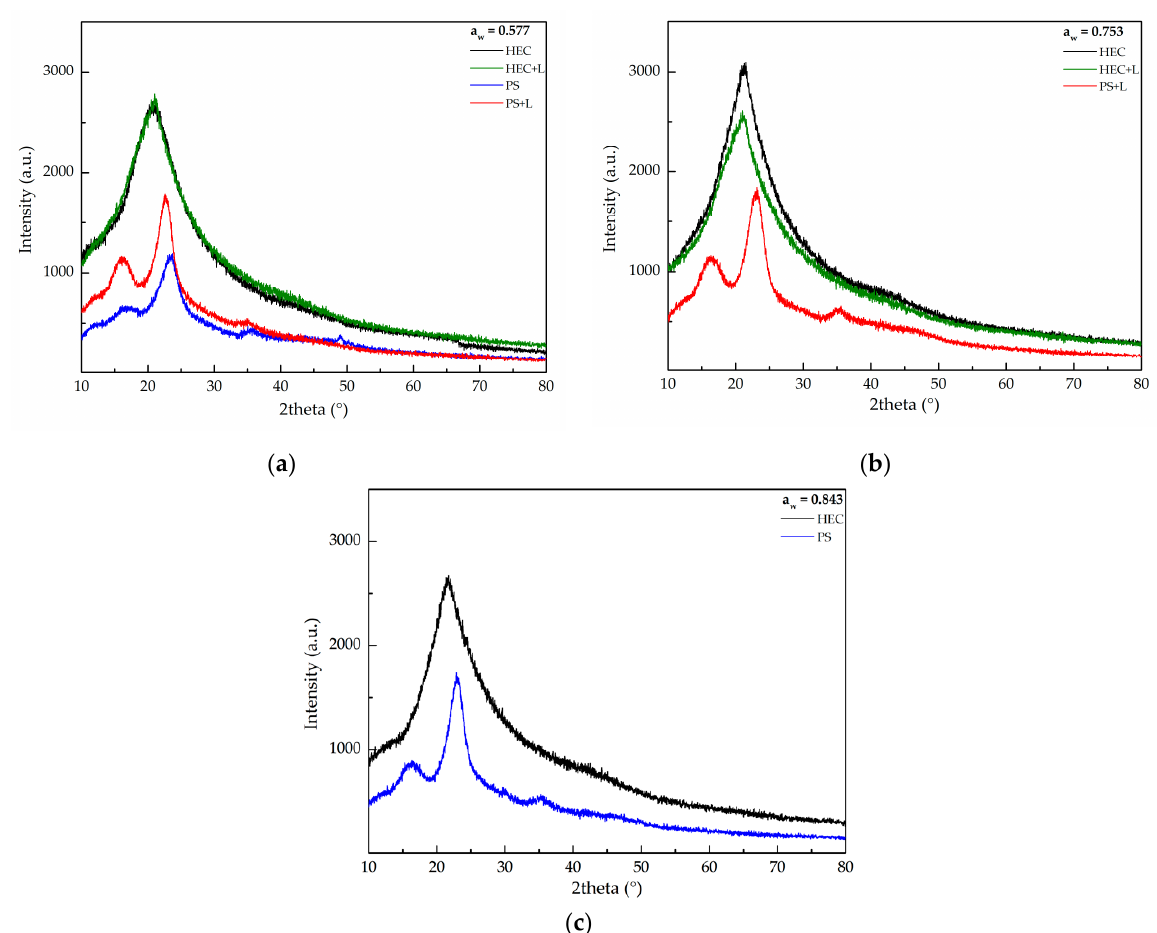
Figure 3. X-ray Diffraction results for HEC and PS films analysis exposed to ( a ) 0.577; ( b ) 0.753; ( c ) 0.843 a w . PS and PS + L films evidenced crystalline peaks around 16 ◦ , 22 ◦ and 35 ◦ , which are typical from cellulose due to its hydrogen bonding interactions and the Van der Waals forces between adjacent molecules, as reported by Meng et al.